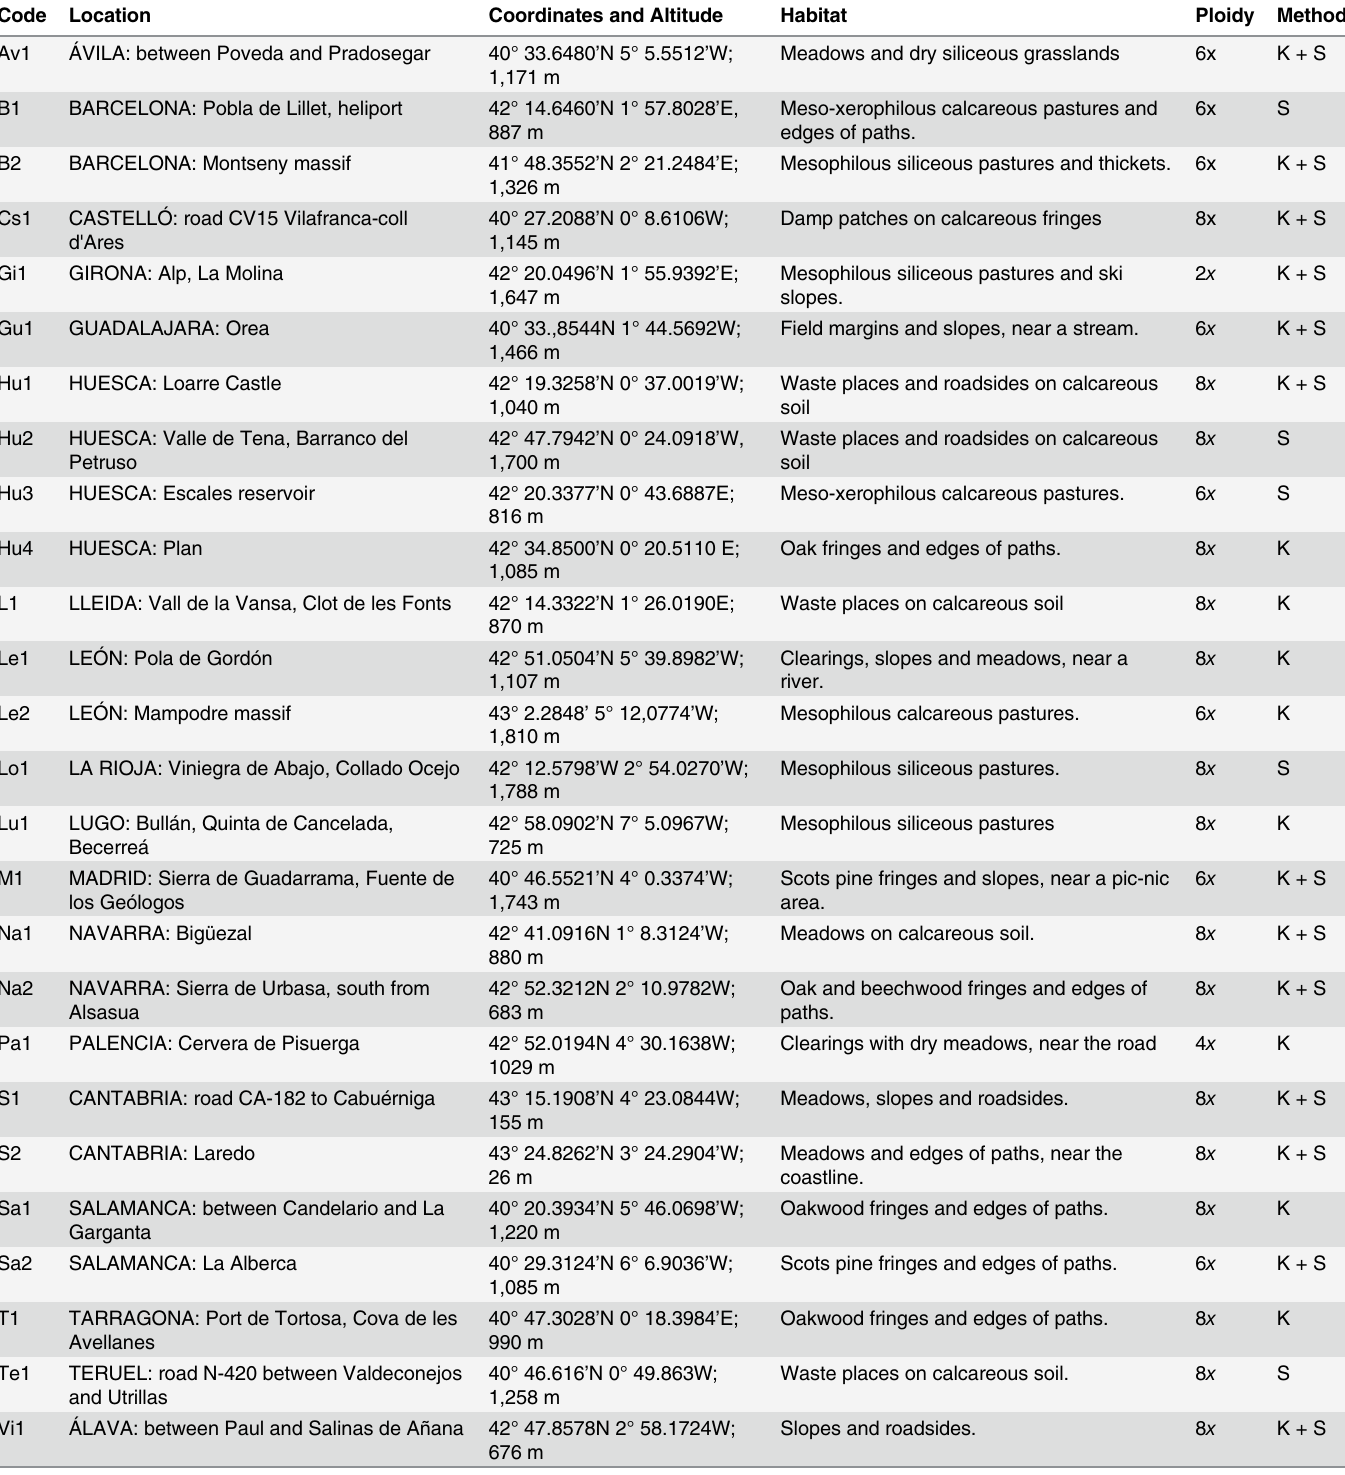
Table 1. Populations of Achillea millefolium investigated in the present study. K: chromosome count; S: stomatal size. Altitudes are expressed in me- ters above sea level. Code